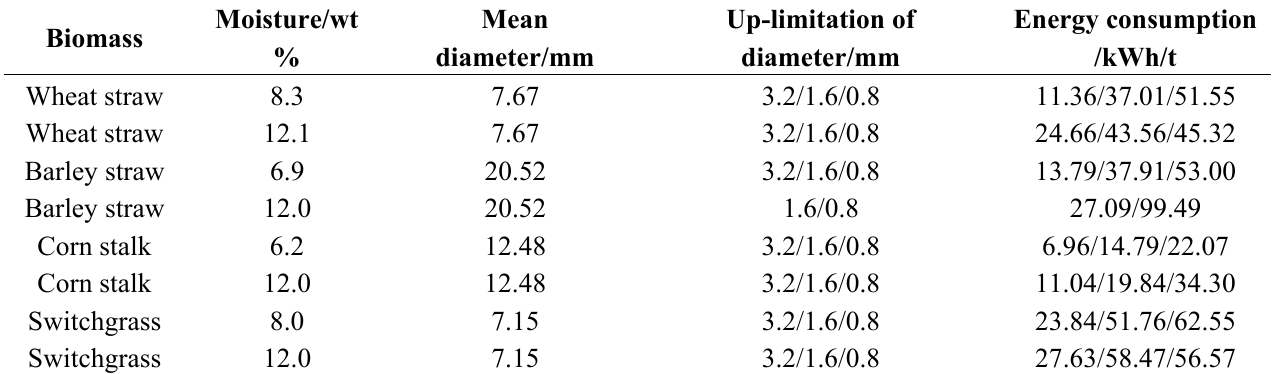
Table 2. Milling energy consumption of hammer mill for different biomass [31].